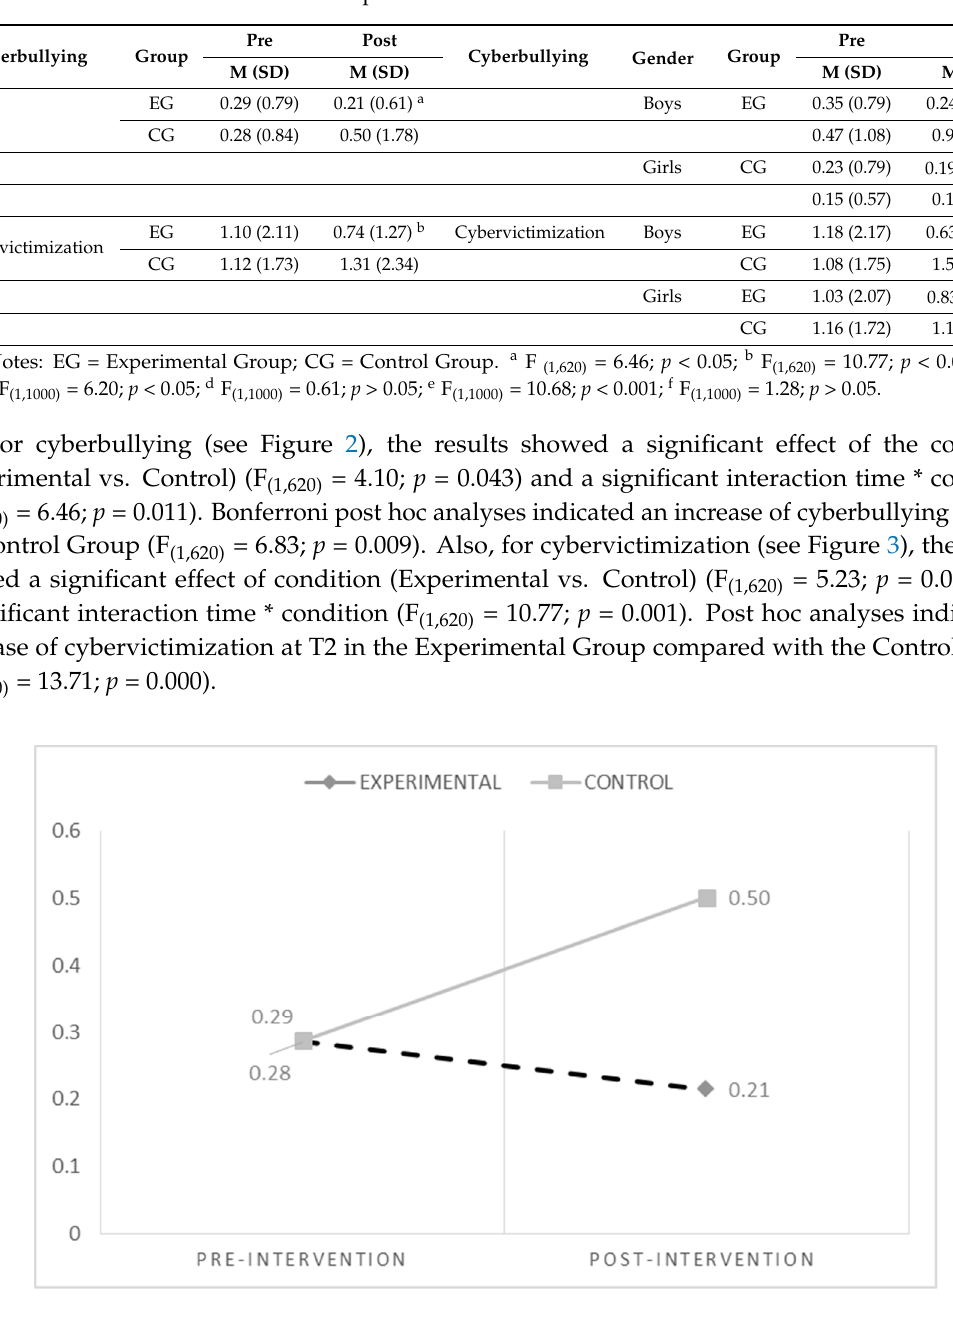
Figure 3. Changes in cybervictimization over time. We tested the effectiveness of the intervention for boys and girls. For this purpose, repeated measures ANOVAs were carried out separately for boys and girls. For cyberbullying (see Figure 4), the results showed a significant interaction time * condition (F (1,1000) = 6.20; p = 0.013) among boys, but a non-significant interaction time * condition among girls (F (1,1000) = 0.61; p = 0.44). Bonferroni post hoc analyses indicated an increase of cyberbullying at T2 among boys of the Control Group (F (1,282) = 9.66; p = 0.002). For cybervictimization (see Figure 5), the results showed a significant interaction time * condition (F (1,1000 ) = 10.68; p = 0.001) among boys, but not for girls (F (1,1000) = 1.28; p = 0.26). The results revealed that both cyberbullying and cybervictimization varied across groups and gender, indicating a significant decrease of both cyberbullying and cybervictimization over time among boys in the EG (but not girls). Post hoc analyses underlined a decrease in cybervictimization at T2 among boys for the Experimental Group (F (1,282) = 11.14; p = 0.001).